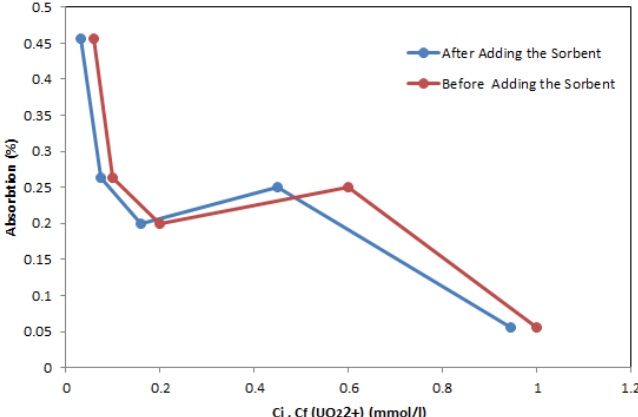
Fig. 11. Equilibrium sorption of uranyl ions by SC yeast as a function of the initial concentration (before addition of the adsorbent) Fig. 11 . and the final concentration of uranyl ions (after addition of the adsorbent) in the solution